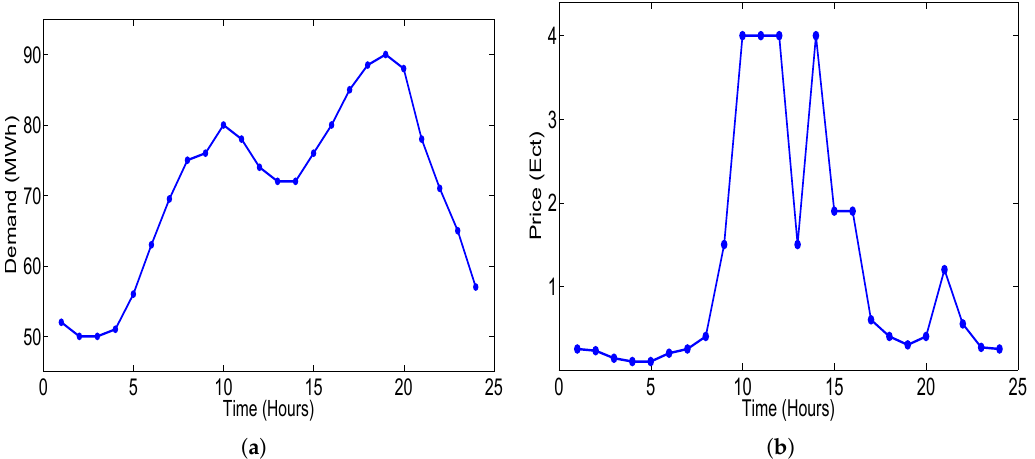
Figure 12. Demand and price data considered for making demand function: ( a ) hourly electricity demand; ( b ) hourly price of